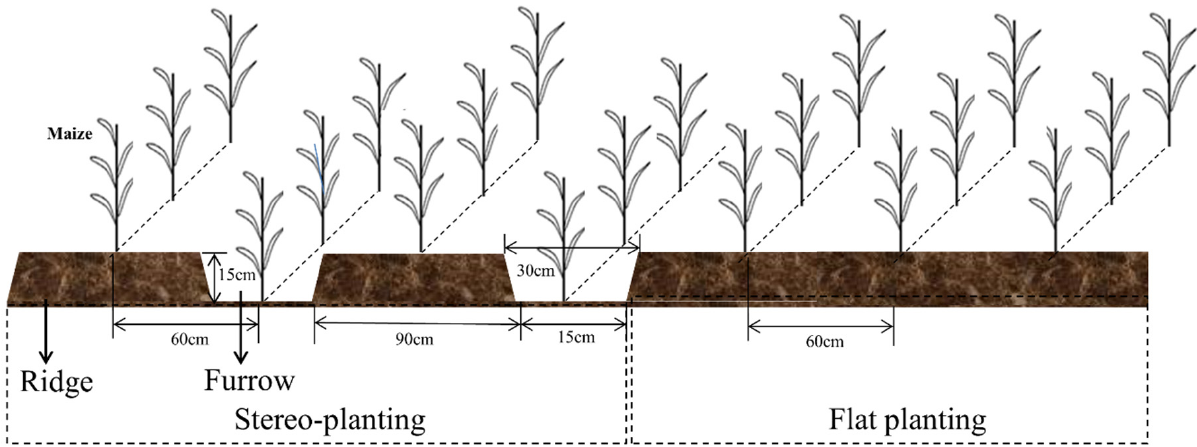
Figure 2. The schematic diagrams of the planting pattern.